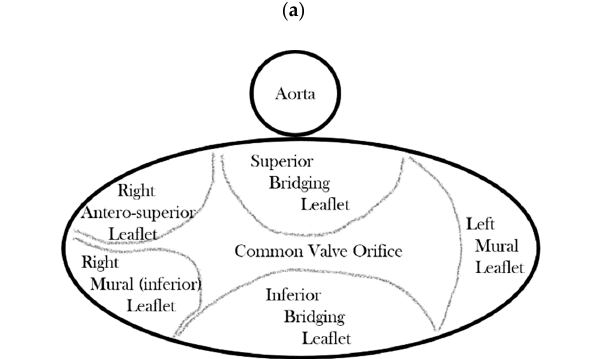
Figure 3. ( a ) Drawing of the atrioventricular junction in Atrioventricular Septal Defect (AVSD) with two valve orifices. ( b ) Drawing of the atrioventricular junction in AVSD with common valve